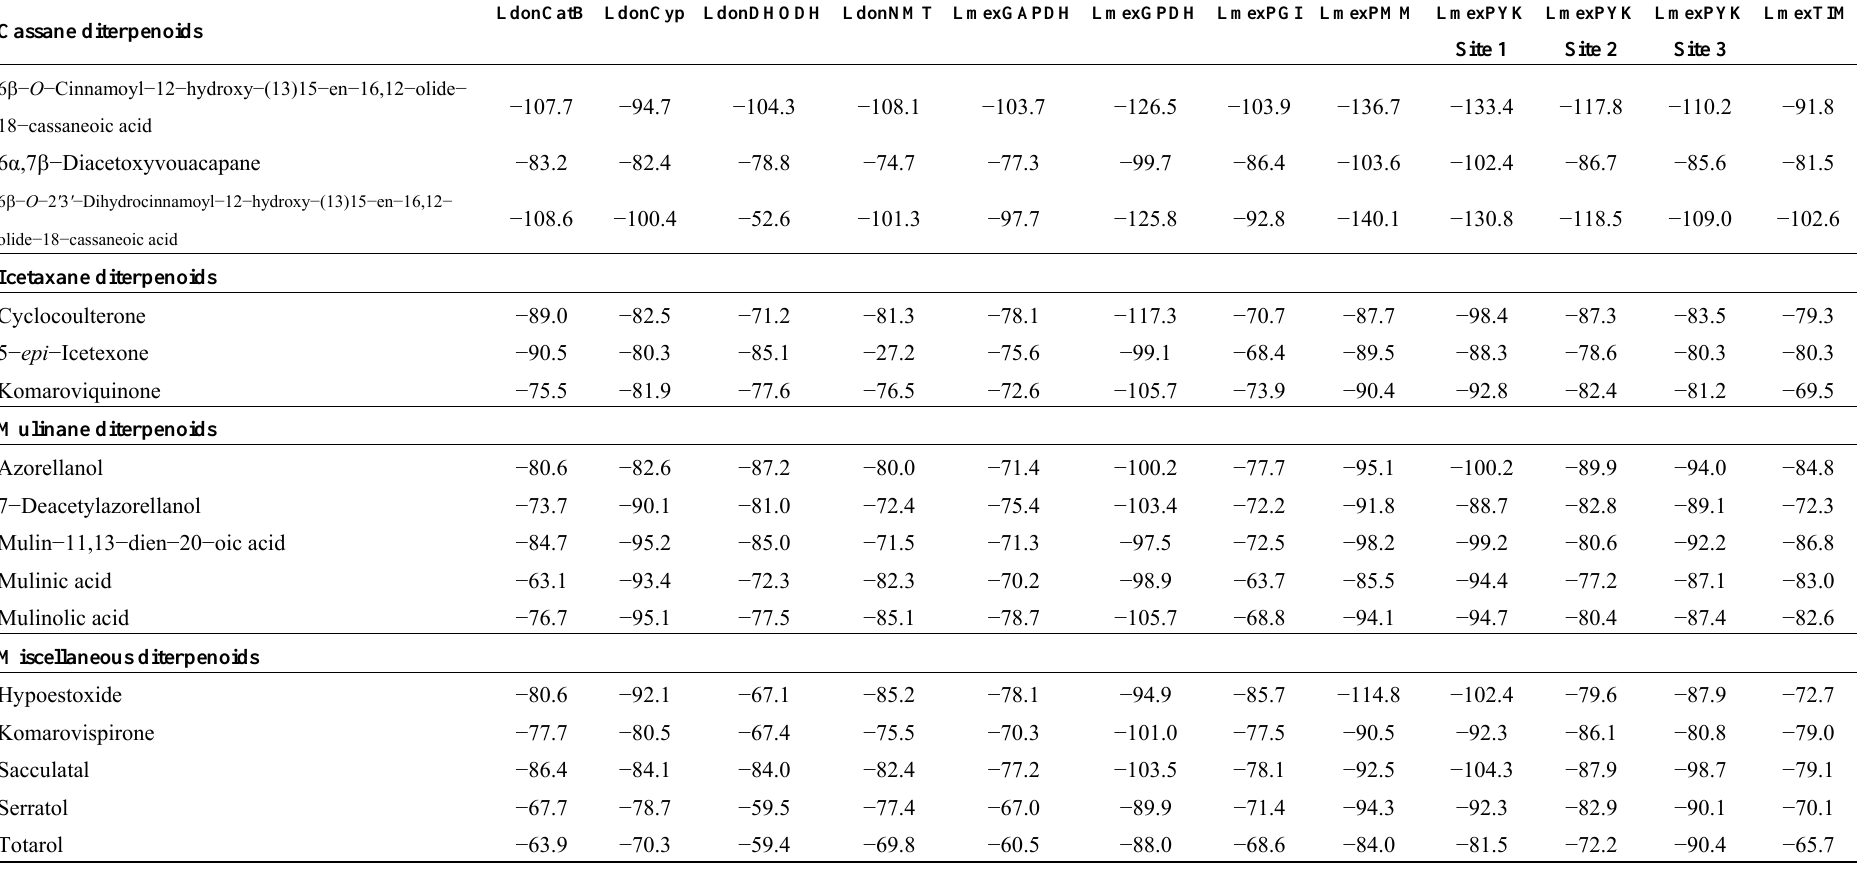
Table 27. MolDock docking energies (kJ/mol) of miscellaneous diterpenoids with Leishmania donovani and L. mexicana protein targets. Cassane